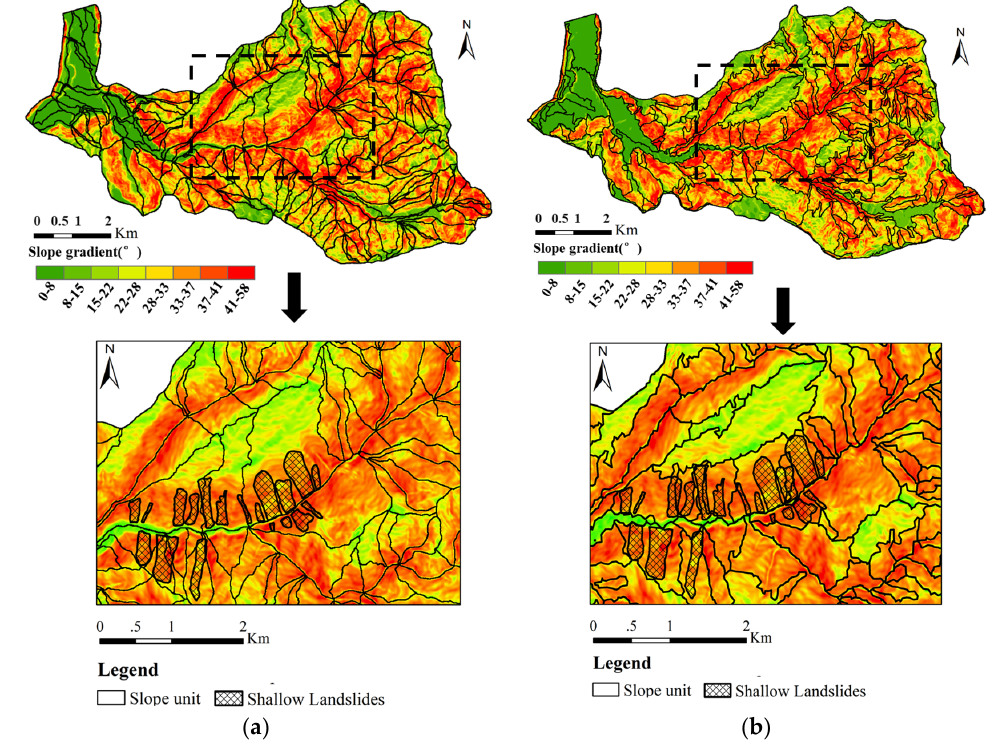
Figure 7. Topographic feature extraction for shallow landslides in Jiangjia Gully area showing results from ( a ) The MIA-HSU method and ( b ) The conventional method.